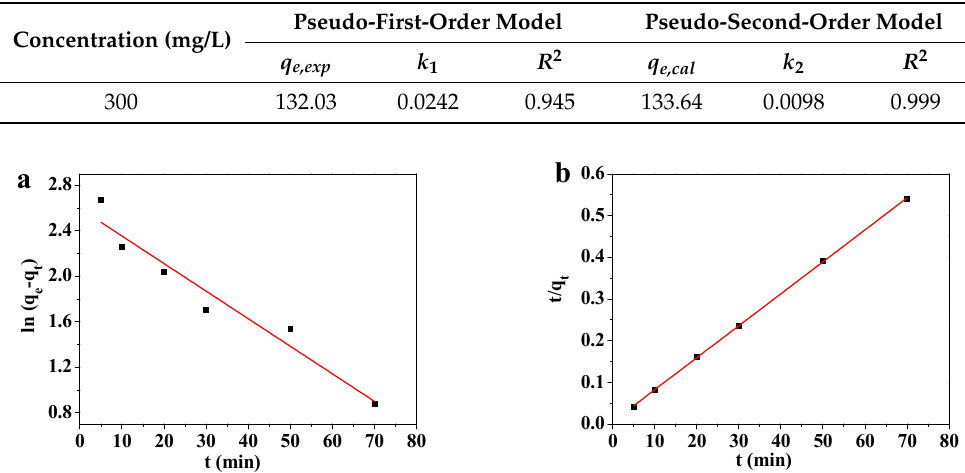
Table 1. Pseudo-first-order and pseudo-second-order kinetic parameters for the adsorption of Pb(II) on MOF-5–CMC beads.